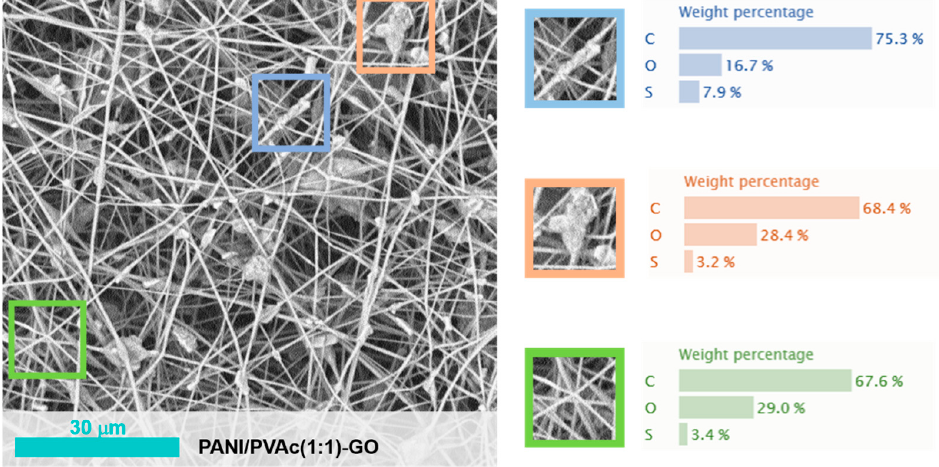
Nanomaterials 2021 , 11 , x FOR PEER REVIEW Figure 7. SEM images of PANI/PVAc(1:1)-GO and delimited EDX profiles . Figure 7. SEM images of PANI/PVAc (1:1)-GO and delimited EDX profiles.